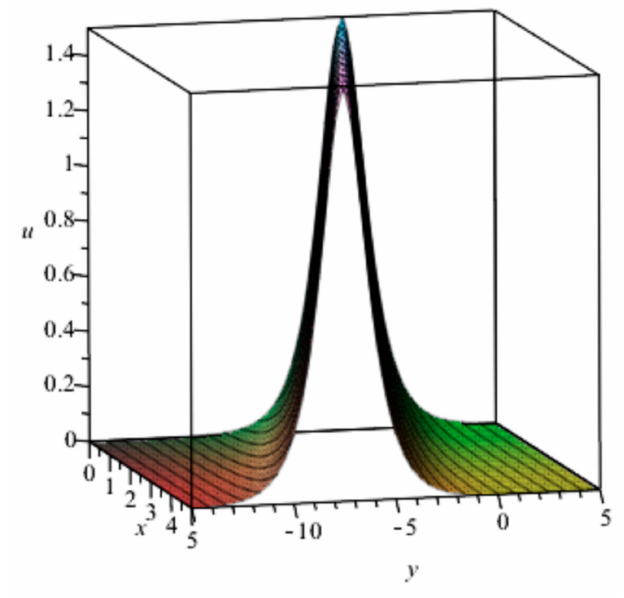
Figure 2. Solution locations for β =